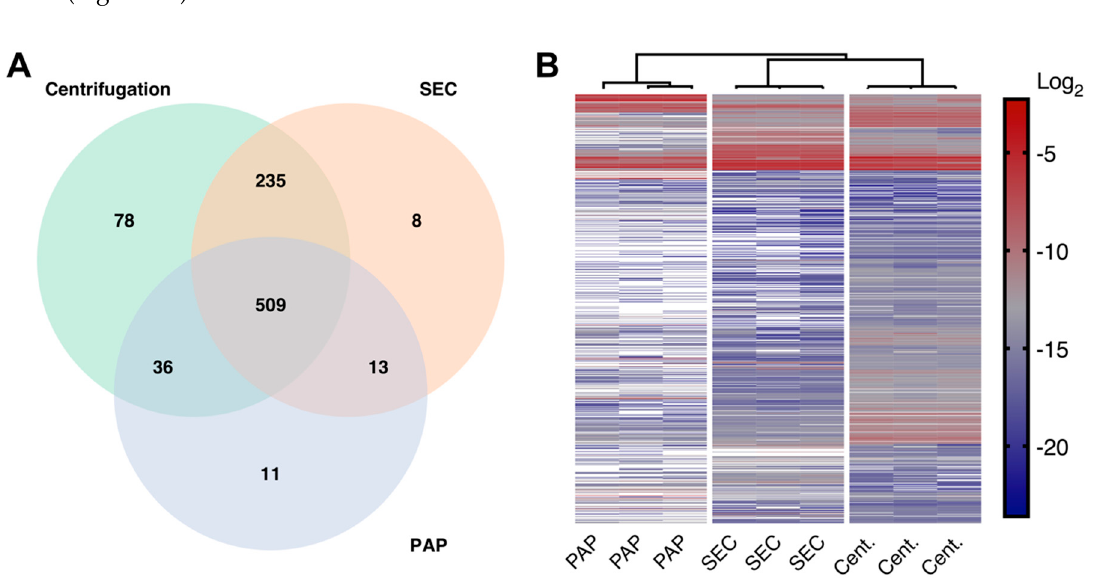
Figure 3. Differences in the EV proteomes in isolates produced by high-speed centrifugation (Cent.), size exclusion chromatography (SEC), and peptide affinity precipitation (PAP). ( A ) Venn diagram showing common and unique proteins identified in all three methods. ( B ) Hierarchical clustering of protein intensities from isolates obtained by high-speed centrifugation, SEC, and PAP showing that the three isolation methods resulted in three distinct EV proteomes. White = missing values.